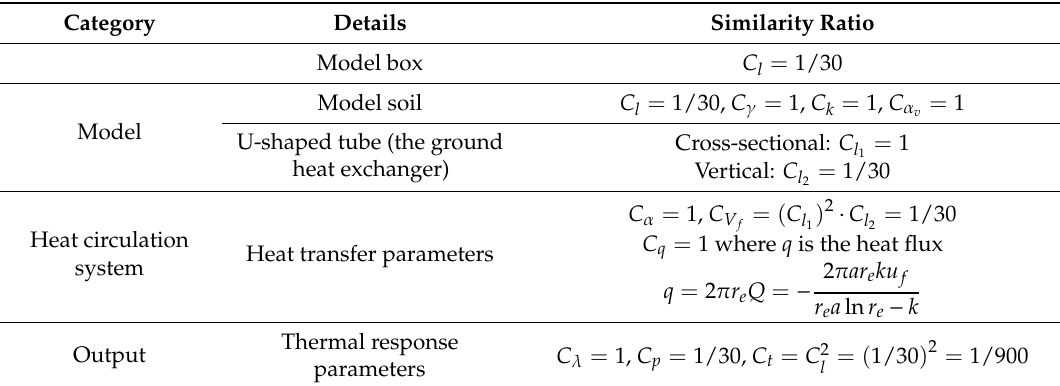
Table 1. Similarity ratios used in the model